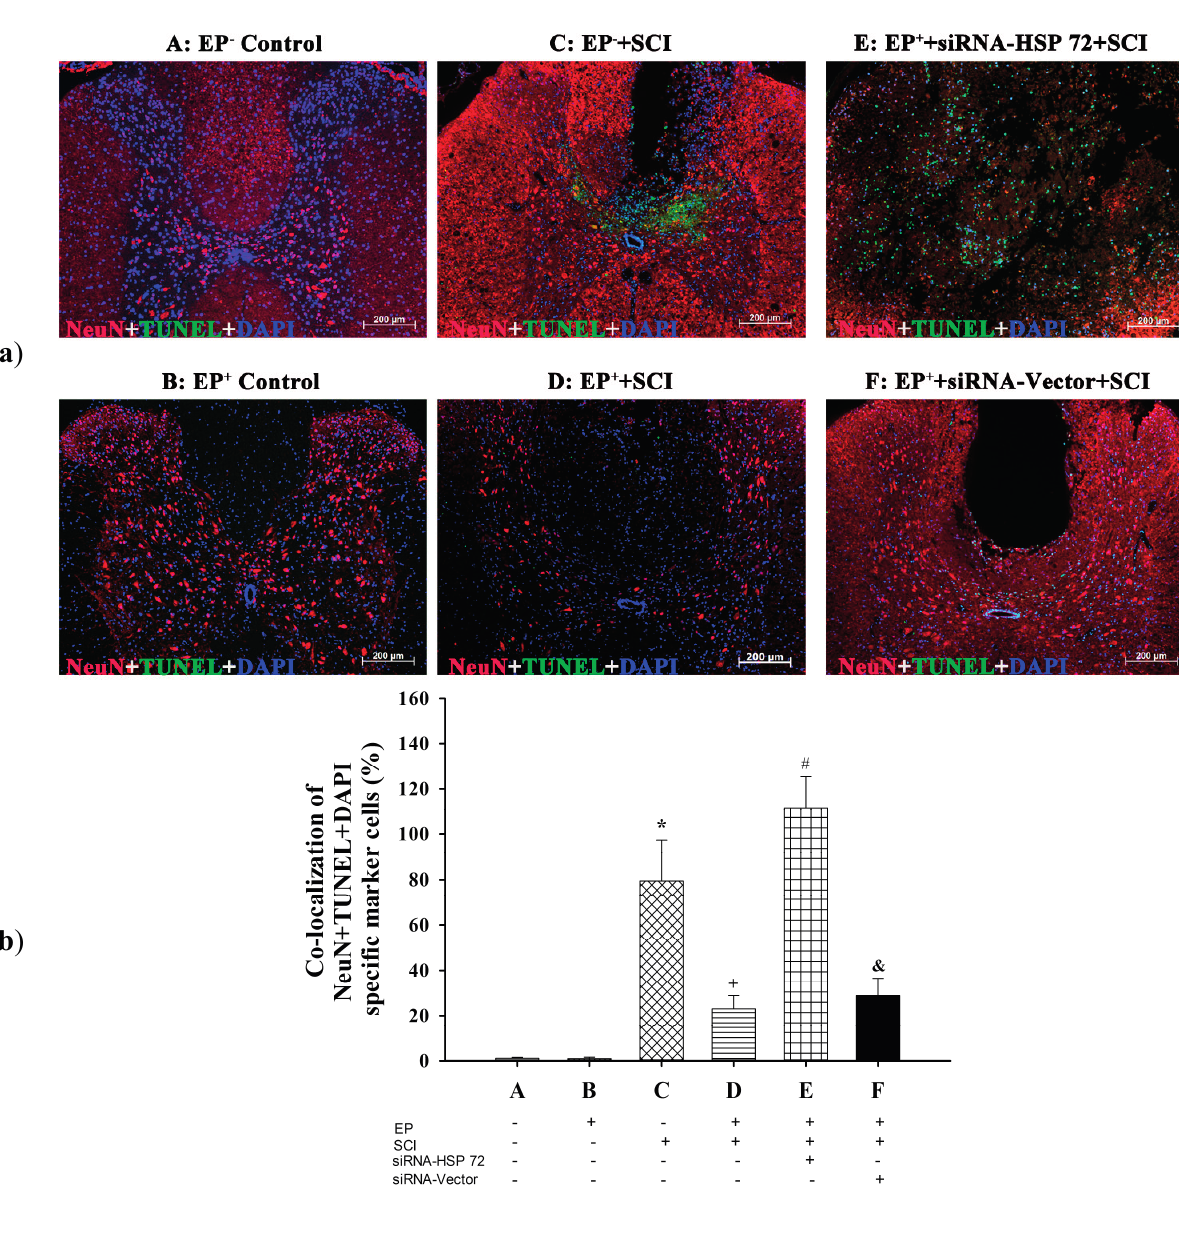
Figure 5. Immunofluorescence detection of apoptotic neurons and apoptotic, astrocytes in the gray matter after spinal cord injury for different groups of rats. Neuronal ( a ) and astrocytic ( b ) apoptosis was revealed by TUNEL staining. The numbers of both apoptotic neurons and apoptotic astrocytes in the lesioned sites were calculated and summed 7 days after injury or sham operation. Please see the legends of Figure 1 for the group abbreviations. The immunofluorescences presented are representative of results from different groups of rats. Values represent mean ± SD of 8 rats per group. * p < 0.01 for C vs. A or B; + p < 0.05 for D vs. C; # p < 0.05 for E vs. D; & p < 0.05 for F vs.